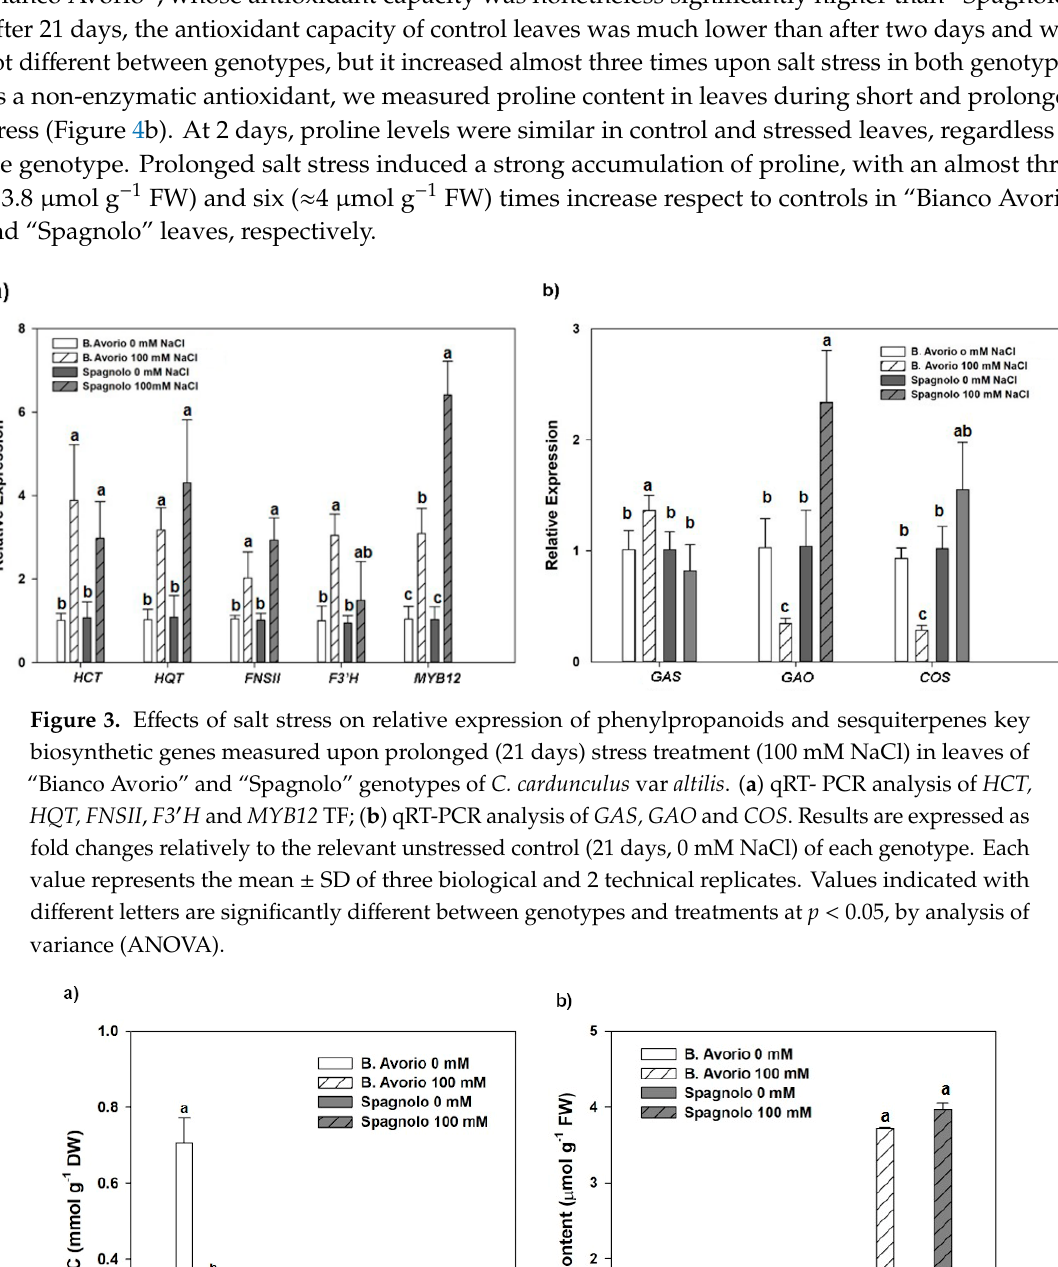
Figure 4. ( a ) Antioxidant activity, measured by ABTS assay and expressed as Trolox equivalent antioxidant capacity (TEAC), and ( b ) proline content in leaves of “Bianco Avorio” and “Spagnolo” genotypes of C. cardunculus var altilis after 2 and 21 days of 0 (control) and 100 mM (salinity treatment) NaCl. Each value represents the mean ± SD of three biological replicates. Values indicated with different letters are significantly different between genotypes and treatments within the same sampling time at p < 0.05, by analysis of variance (ANOVA).